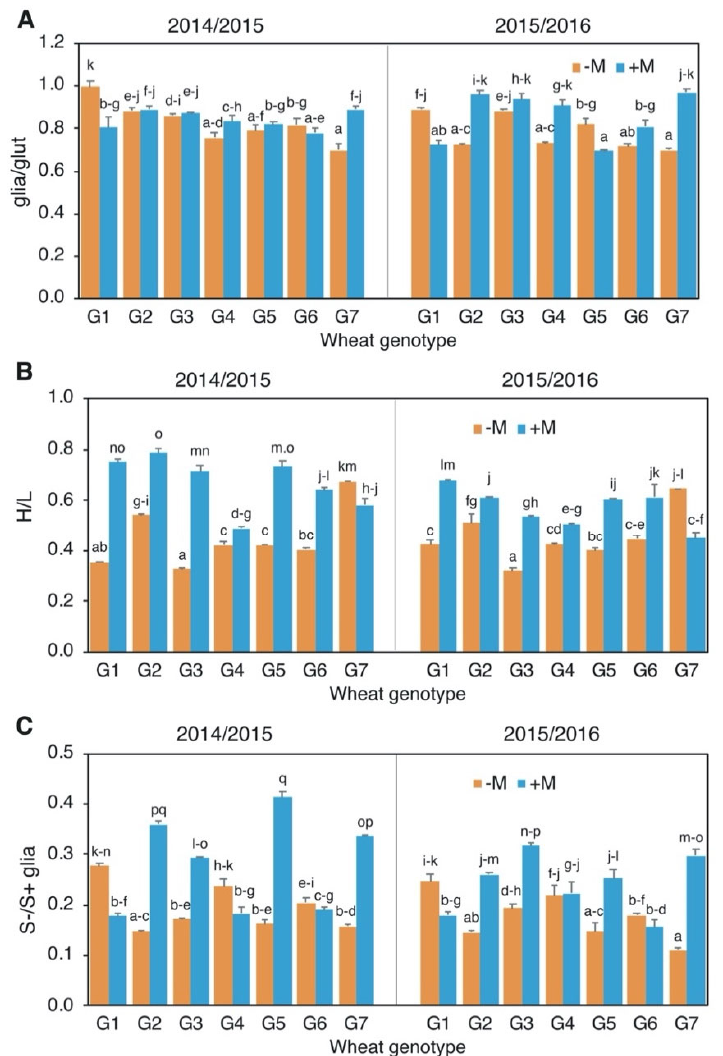
Figure 5. Effect of the interaction among wheat genotype (G), arbuscular mycorrhizal fungal inoculation (AMF), and year of cultivation (Y) (G × AMF × Y) on glia/glut ( A ), H/L ( B ), and S − /S+ glia ( C ). − M: mock-AM fungal inoculated treatment (control); +M: AM fungal inoculated treatment. Wheat genotypes: G1: Gentil Rosso; G2: Risciola; G3: Frassineto; G4: Autonomia B; G5: Verna; G6: Blasco; G7: Bologna. Data are mean ± SE. Different letters indicate significant differences at P < 5% according to Tukey B test.